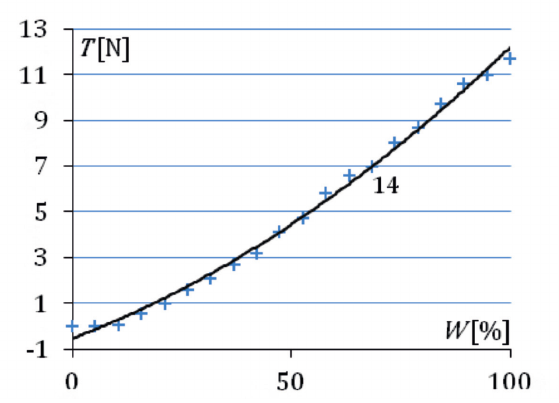
Fig. 5. Thrust versus PWM duty